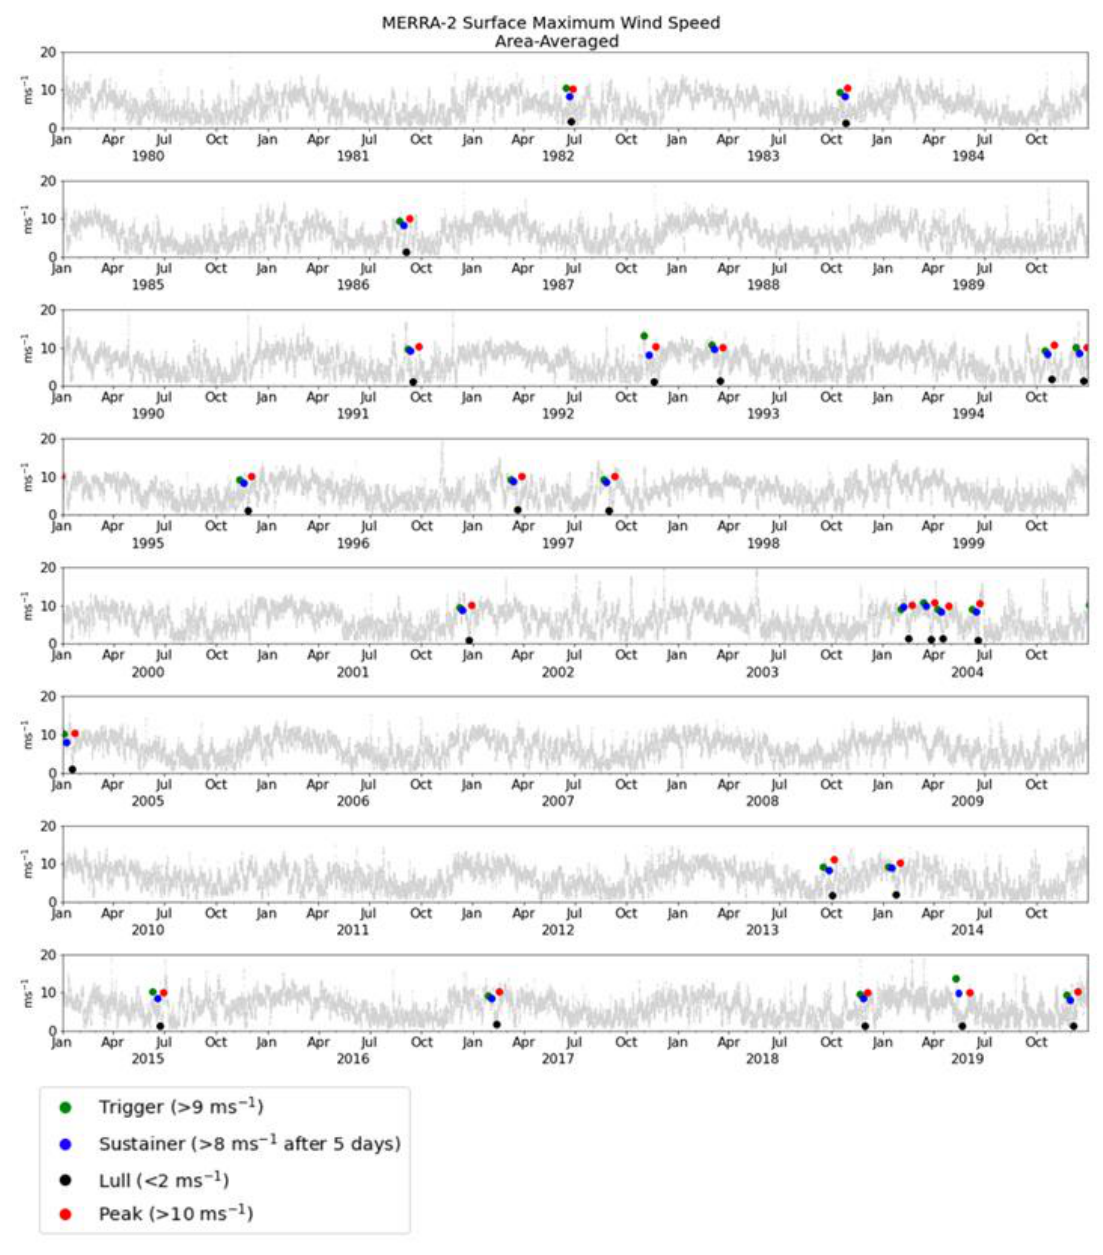
Figure 6. Digital filter results for the 40-year time series (1980–2019) of MERRA-2 surface maximum windspeed data for the Chuuk Lagoon region. The colored dots show the sequence of events which was searched, consisting of (green) trigger event, (blue) sustaining event, (black) lull event, and (red) transport event. This analysis therefore engendered the question: is there a unique characteristic of the winds during the September – October period?